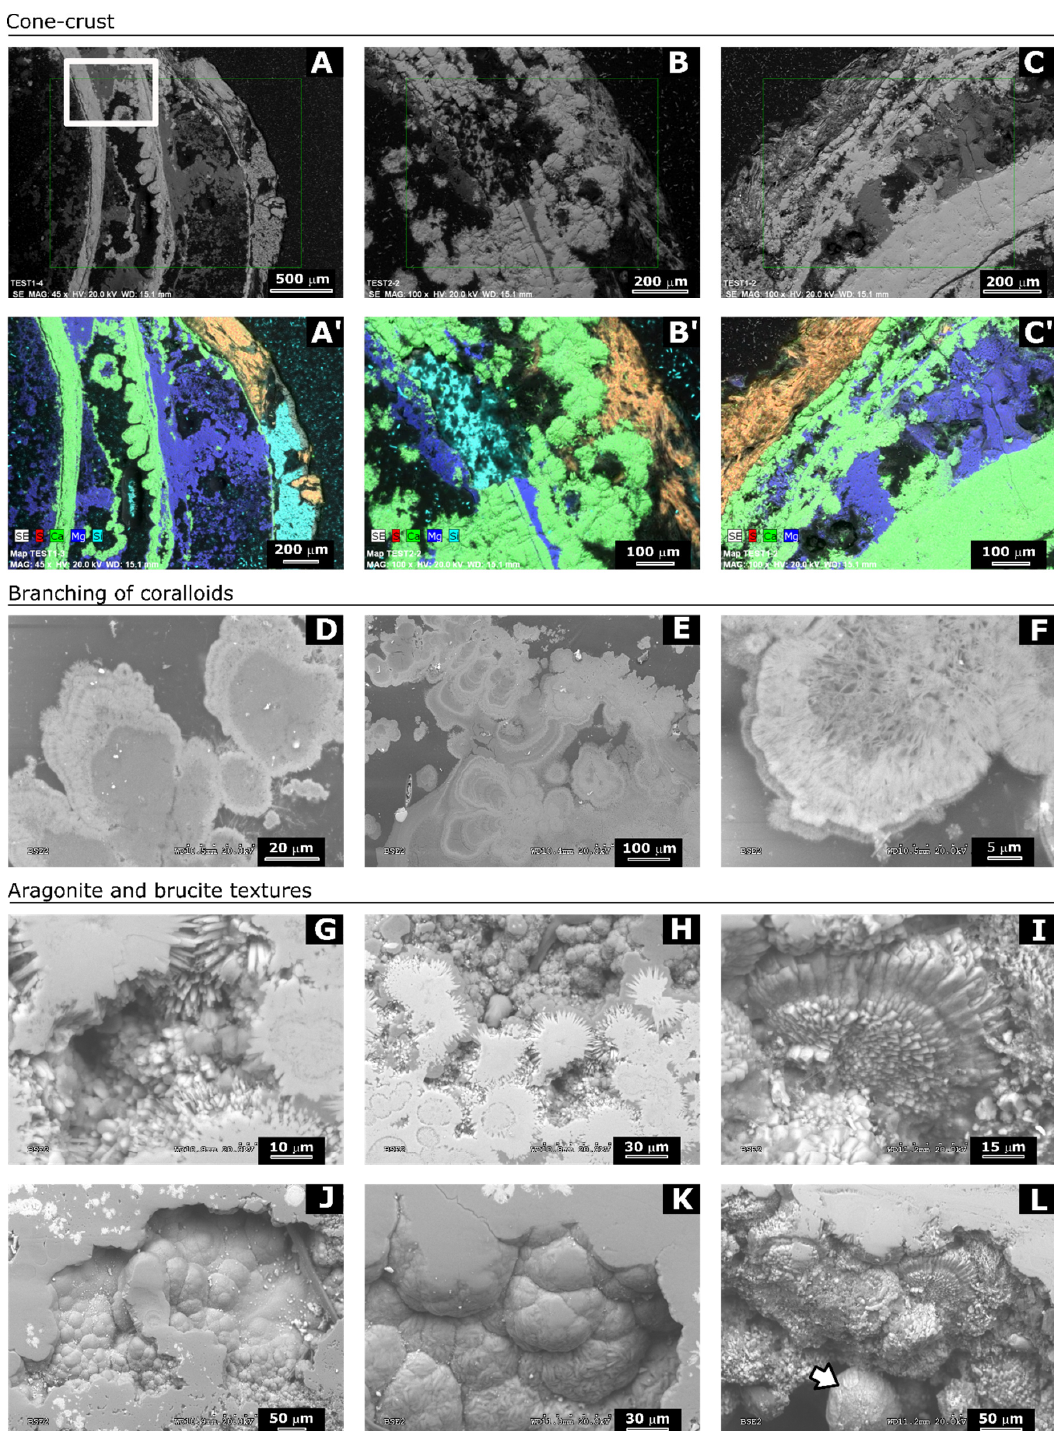
Figure 5. Scanning electron microscope in backscattering electron mode (BSE-SEM) images ( A – L ) and geochemical mappings ( A’, B’, and C’ ) of different parts of the stalactite. Colour code of the geochemical maps: green > Ca; blue > Mg; orange > S; and turquoise > Si. Grey level code of BSE-SEM images: dark grey > brucite; light grey > aragonite. Images ( G – H ) correspond to aragonite textures in the branching of coralloids. Images ( J,K ) correspond to brucite botryoidal textures in the branching of coralloids. Image ( L ) shows aragonite radial textures of the cone-crust (image ( I ) shows a detail of a fibrous aragonite crystals fan). The arrow in image ( L ) indicates a sphere of brucite on the surface of the aragonite precipitate.